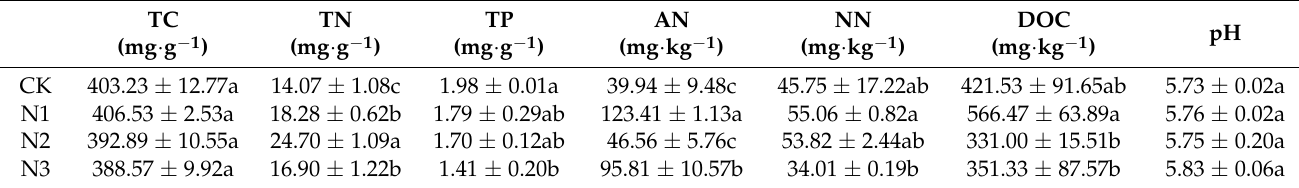
Table 1. Effects of nitrogen addition on the content of soil carbon, nitrogen and phosphorus. Values are means ± standard error ( n = 3). TC: total carbon; TN: total nitrogen; TP: total phosphorus; AN: ammonium nitrogen; NN: nitrate nitrogen; DOC: dissolved organic carbon. CK: 0 g N · m − 2 · year − 1 ; N1: 6 g N · m − 2 · year − 1 ; N2: 12 g N · m − 2 · year − 1 ; N3: 24 g N · m − 2 · year − 1 . Different letters indicate a significant difference among different concentrations of nitrogen addition treatments ( p < 0.05) as estimated by one-way ANOVA and a post hoc Duncan’s multiple-range test.